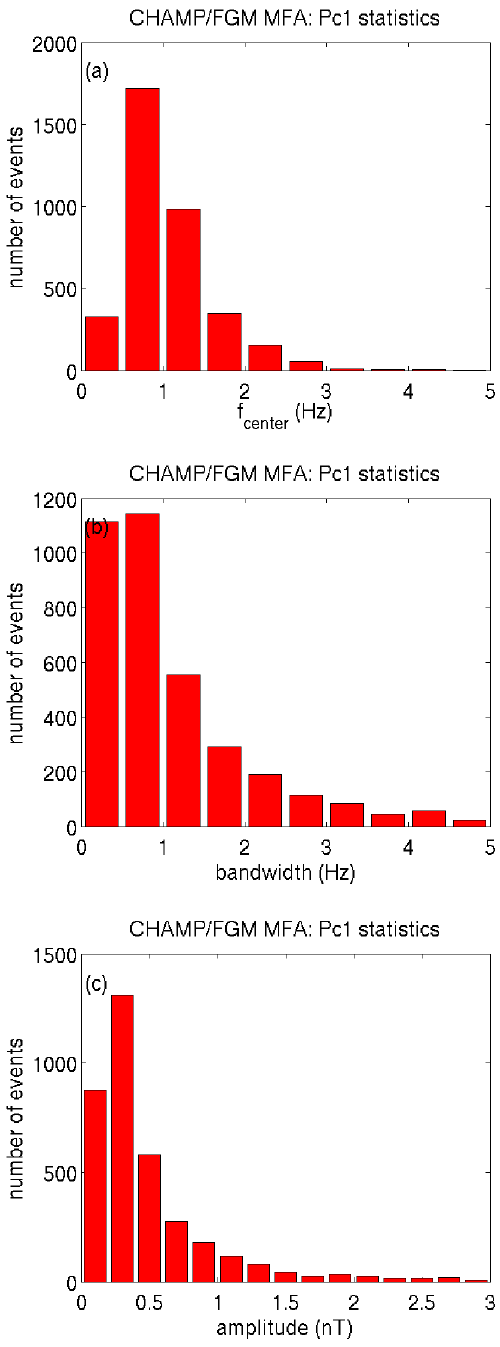
Fig. 3. Solar cycle variation of the Pc1 polarization properties: (a) degree of polarization, (b) ellipticity, (c) azimuth angle between the major axis and the zonal direction. The black dots show all the Pc1 events, and the red squares represent annual median values, with their range of quartiles shown as dashed